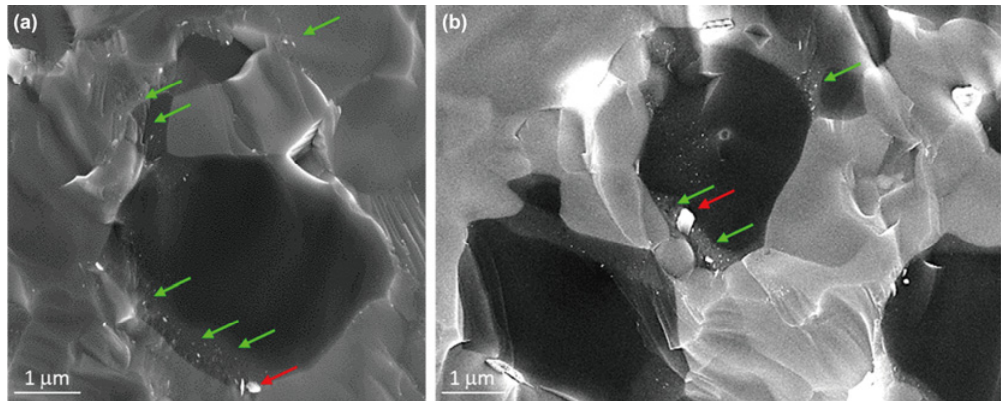
Fig. 6 SEM fracture surfaces of the ZTC-B ceramic showing nanotexturing in the solid solution area. Larger particles are highlighted by red arrows, small ones by green arrows.